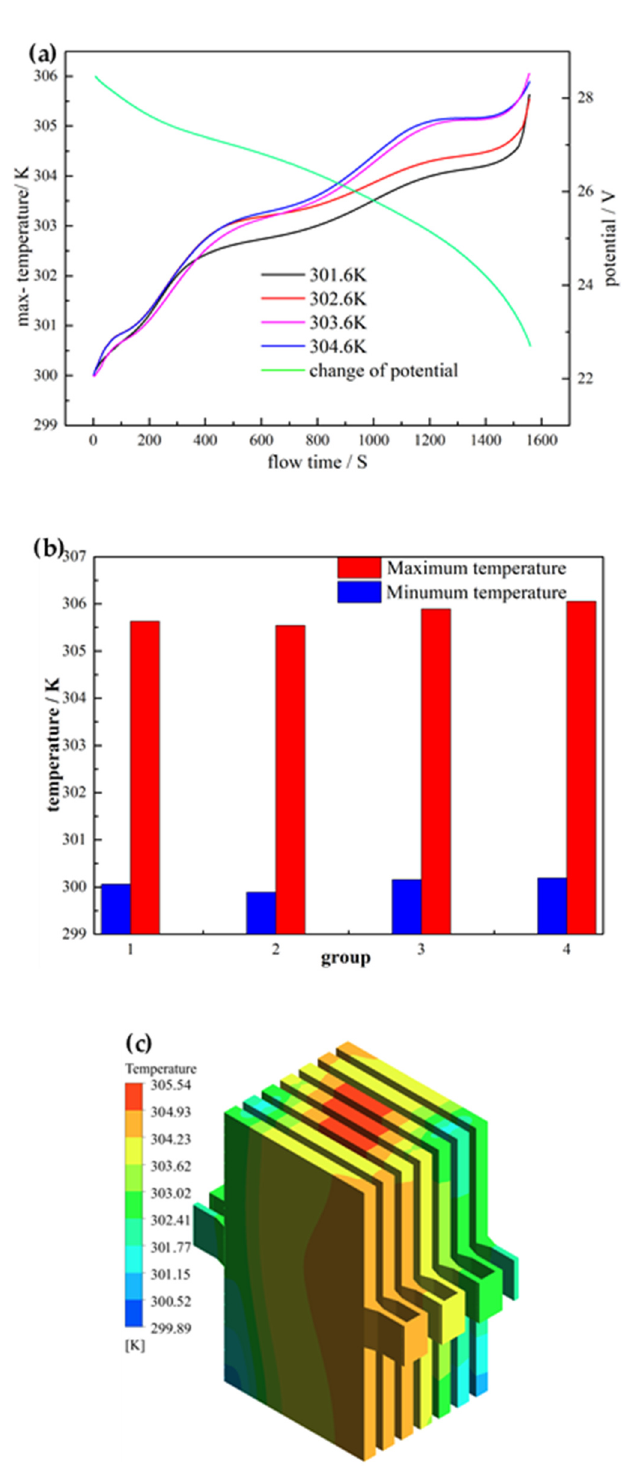
Figure 8. ( a ) Maximum and minimum temperature varying with pipe position; ( b ) maximum and minimum temperature for different PCM melting temperatures: groups 1–4 correlate to 301.6 K, 302.6 K, 303.6 K, and 304.6 K, respectively; ( c ) temperature distribution using 302.6 K PCM melting temperature.